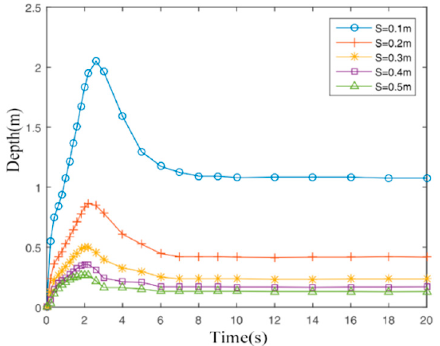
Figure 6. The relationship between scour depth and time at different standoff distances.